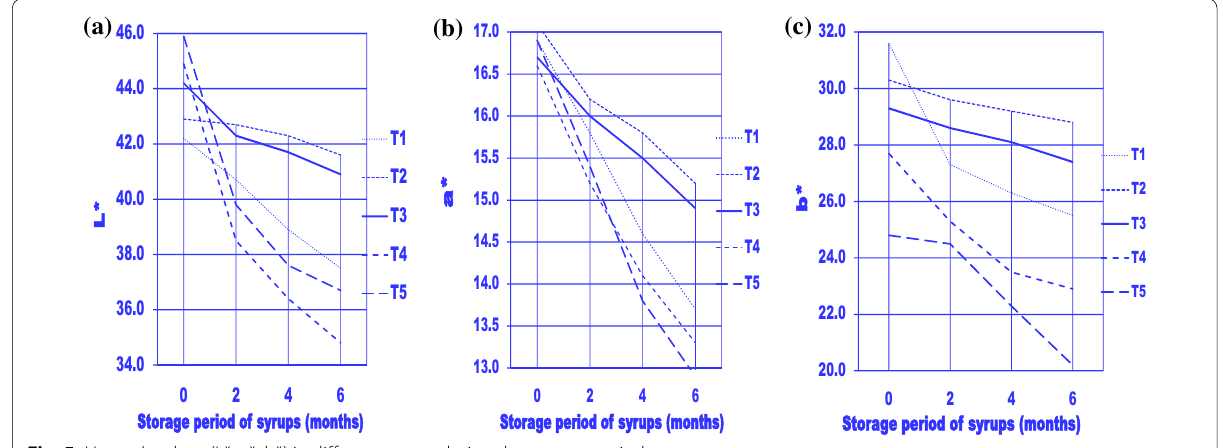
Fig. 5 Hunter’s values (L*, a*, b*) in different syrups during the storage